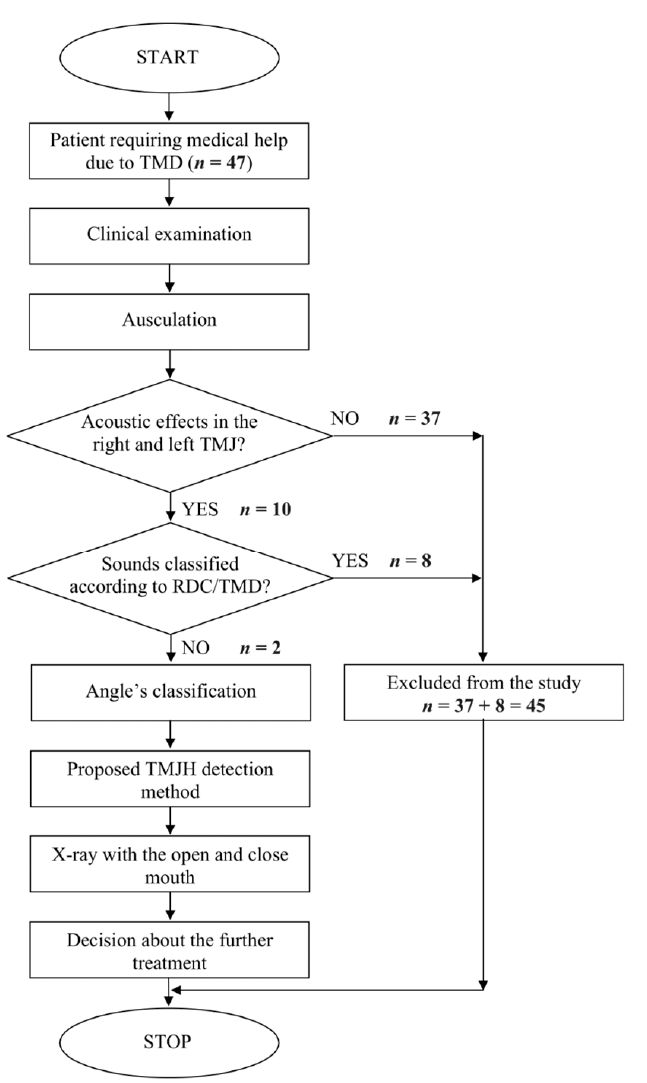
Figure 1. Flowchart of research procedure. TMJH: hypermobile temporomandibular joint; TMD: temporomandibular disorders; RDC/TMD: Research Diagnostic Criteria for Temporomandibular Disorders.